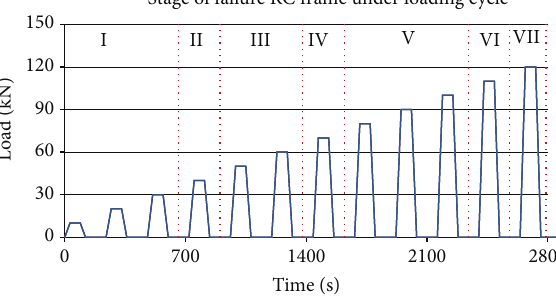
Figure 2: A typical cracks development in the RC frames specimen.